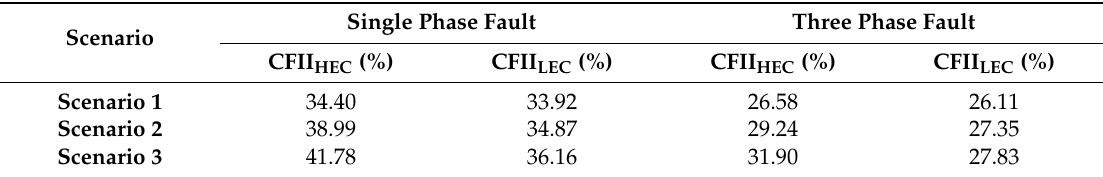
Table 1. CFII HEC and CFII LEC Values for Three Scenarios under Single and Three Phase Fault